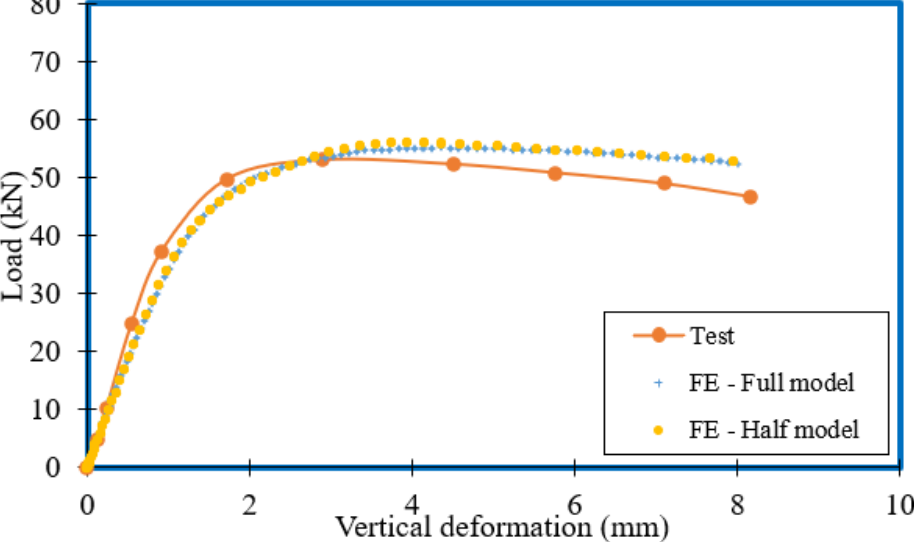
Figure 7. Load–vertical deformation comparison of ETF H120X120X4 with a bearing plate length of 60 mm [2,5].